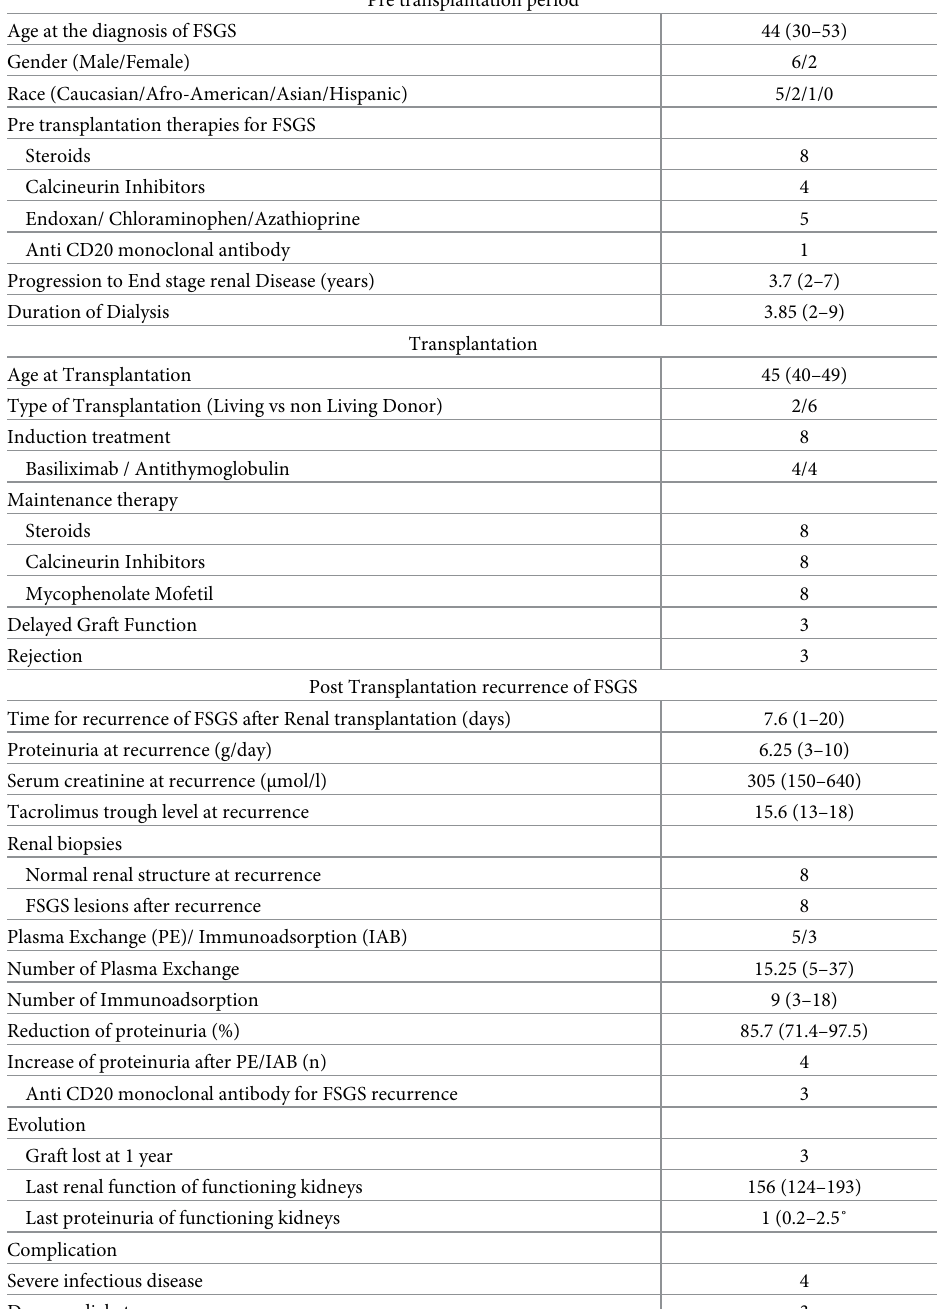
Table 1. Clinical characteristics of patients with post transplantation recurrent